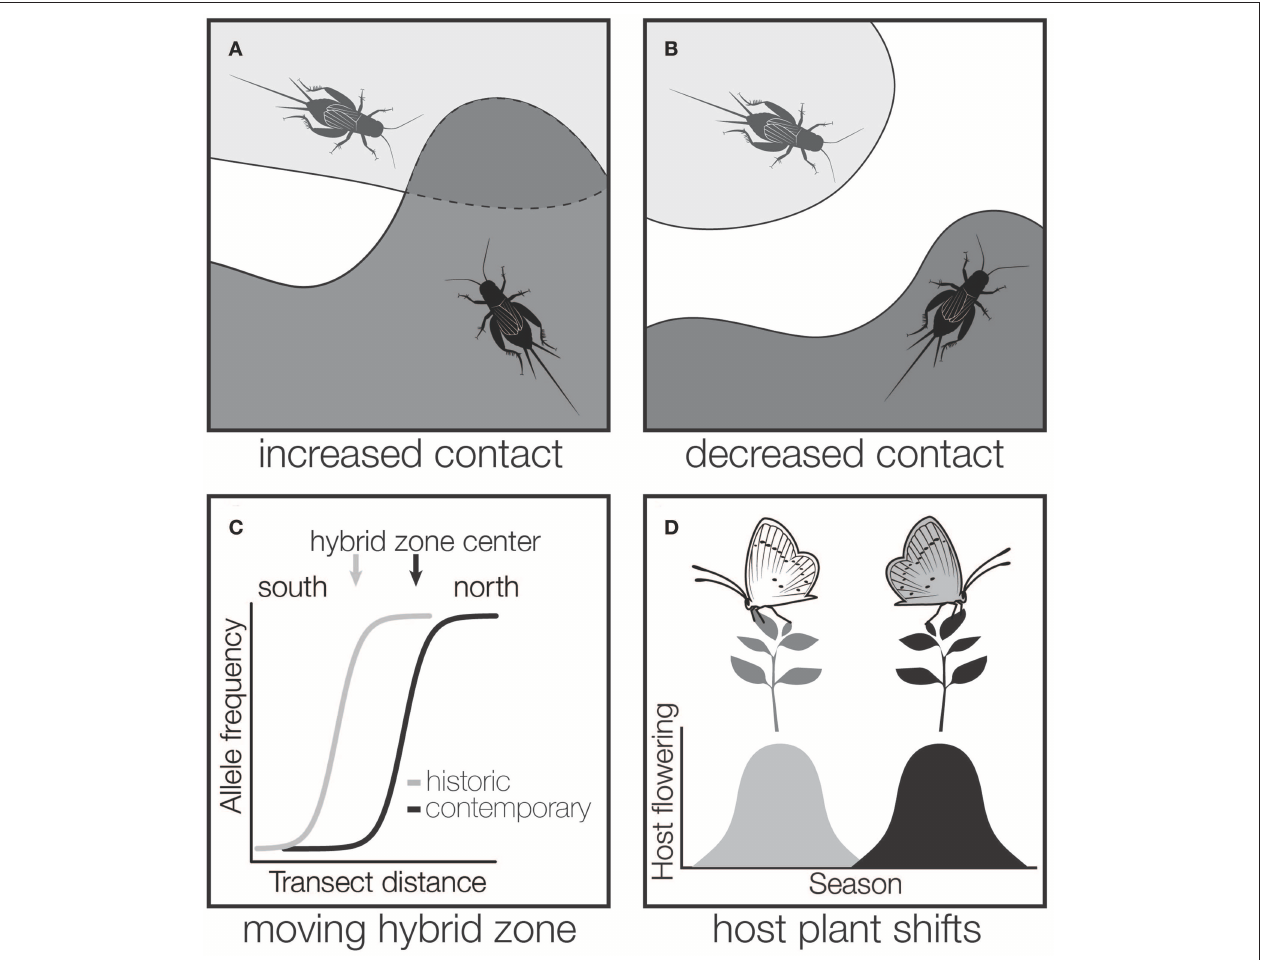
FIGURE 2 | Possible outcomes of insect range changes on the potential for hybridization. As insect ranges change due to climate, we can expect that some species that were previously allopatric will have new areas of contact (A) . Likewise, ranges may shrink for some species or populations, potentially decreasing hybridization or gene flow (B) . Species that already interact in hybrid zones may experience new species interactions (e.g., changing species densities, new environmental contexts) as hybrid zones shift with changing species ranges (C) . As species occupy new habitat, there is the potential for herbivorous insects to shift to new host species, leading to increased or decreased contact with other species (D)